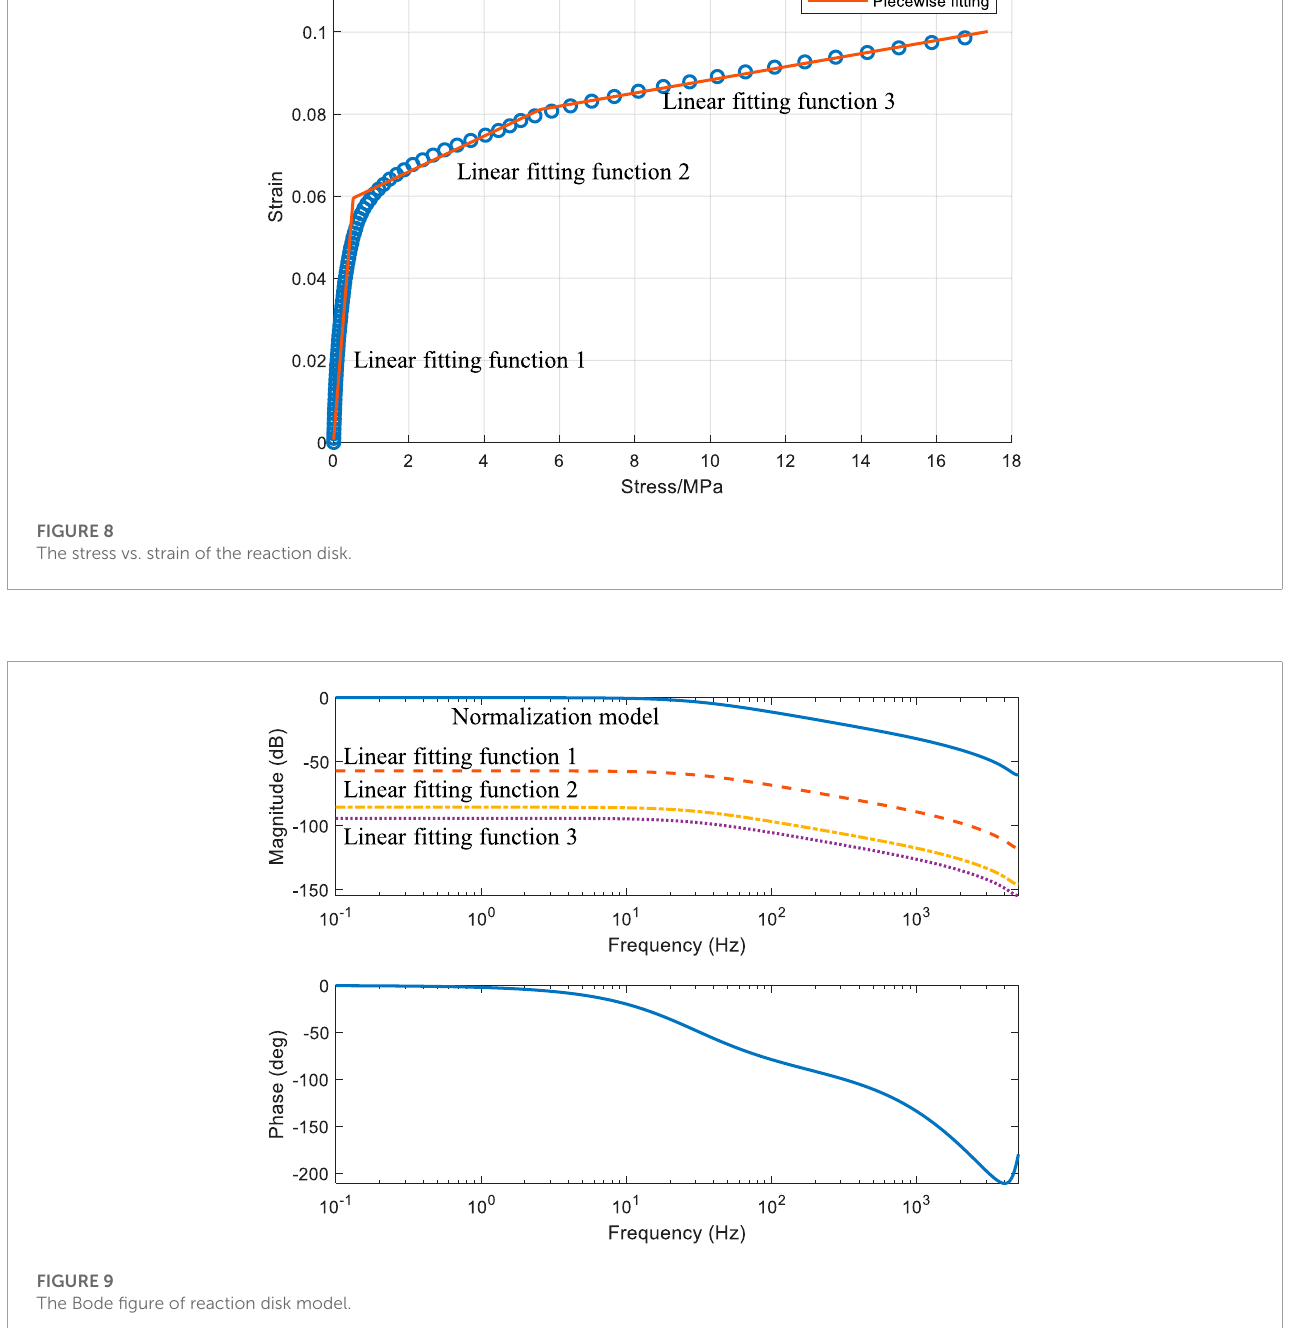
FIGURE 9 The Bode figure of reaction disk